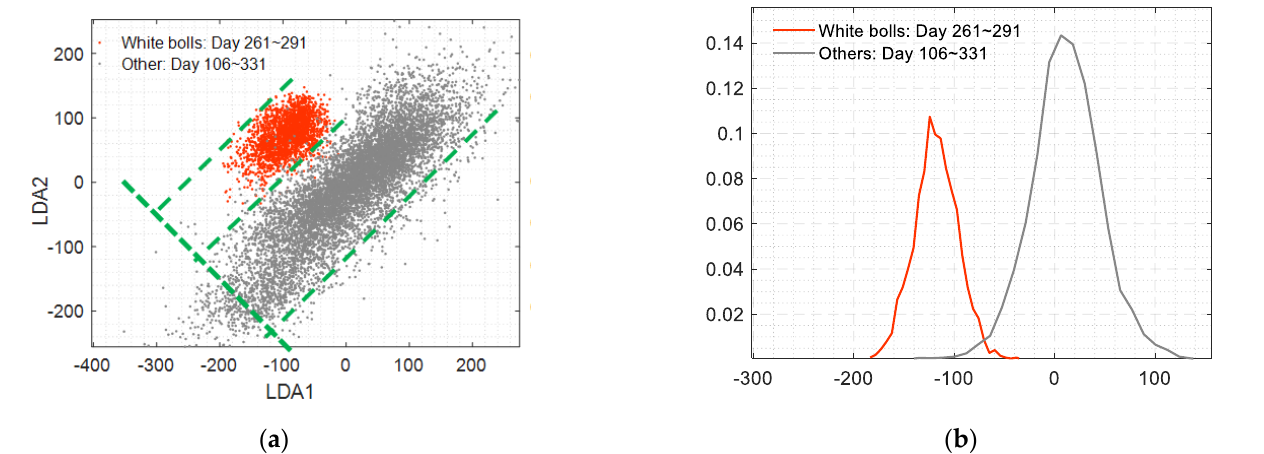
Figure 6. ( a ) Scatter plot for white bolls and others (including cotton in other stages, corn, sorghum, soybean, rice, and peanuts in growth period) based on LDA1 and LDA2. ( b ) The histogram of the projected points in ( a ) along the green line, which shows the separation degree between white bolls and others.